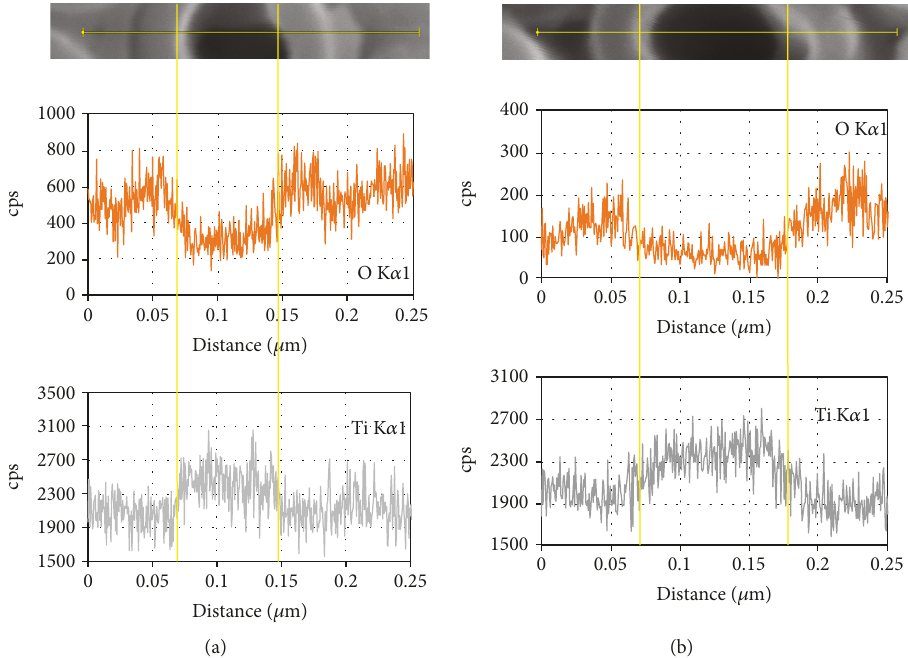
Figure 2: EDX linescan along the diameter of the tube showing oxygen and titanium distributions for (a) sample 125 ° C and (b) 450 ° C samples.